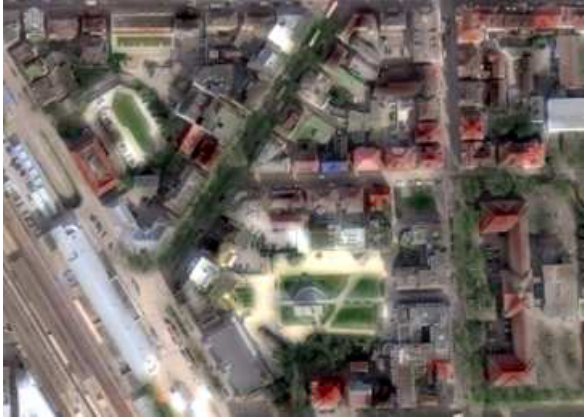
Figure 4: RGB channels of the Gram-Schmidt Fusion image